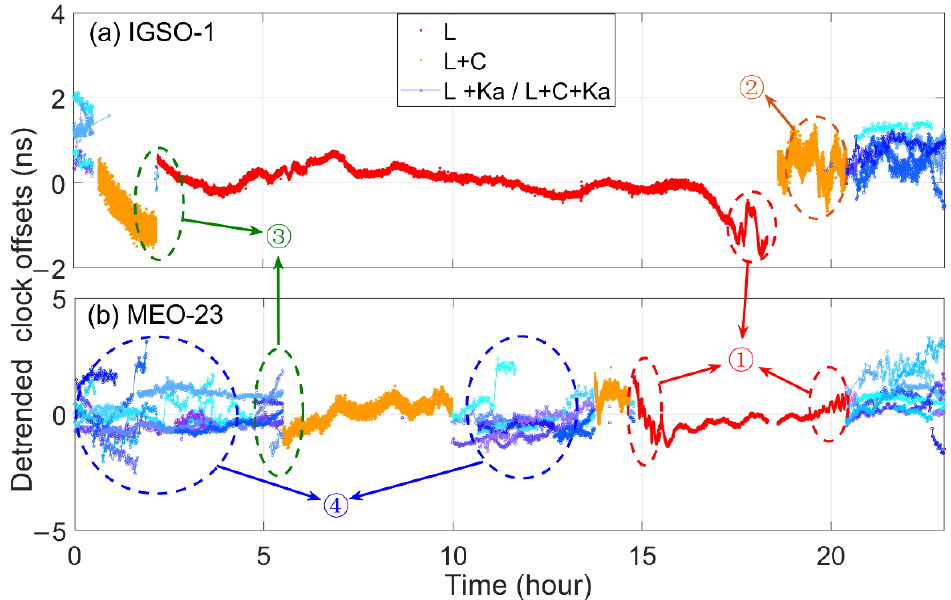
Figure 3. The typical one-day detrended two-way clock offsets of IGSO and MEO measured by BDS-3 two-way superimposition strategy. ① – ④ describe the problems and abnormal phenomena in the two-way superimposition strategy.